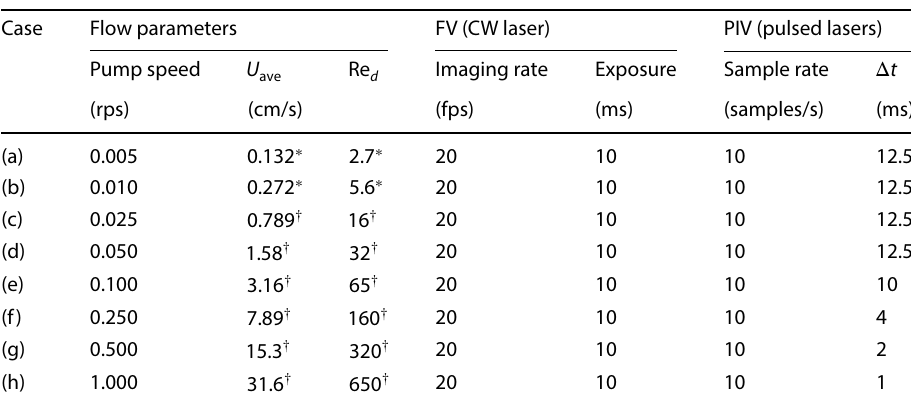
Table 1 Summary of